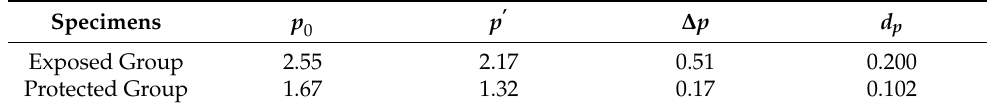
Table 4. Pore damage calculation